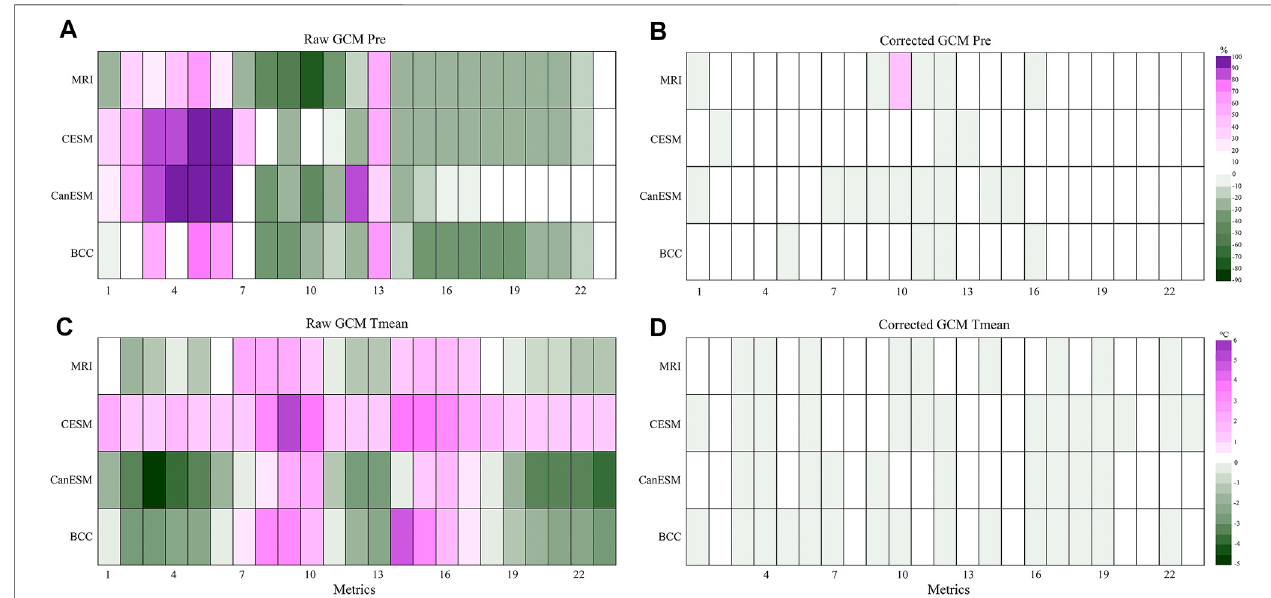
FIGURE3| Portraitdiagramofdailyprecipitationrelativedeviation(%)andtemperatureabsolutedeviation( ° C)fortheselectedGCMsbeforeandafterDBCmethod in Xixian basin. The x -axis represents the 23 metrics, whereas the y -axis represents the GCMs.